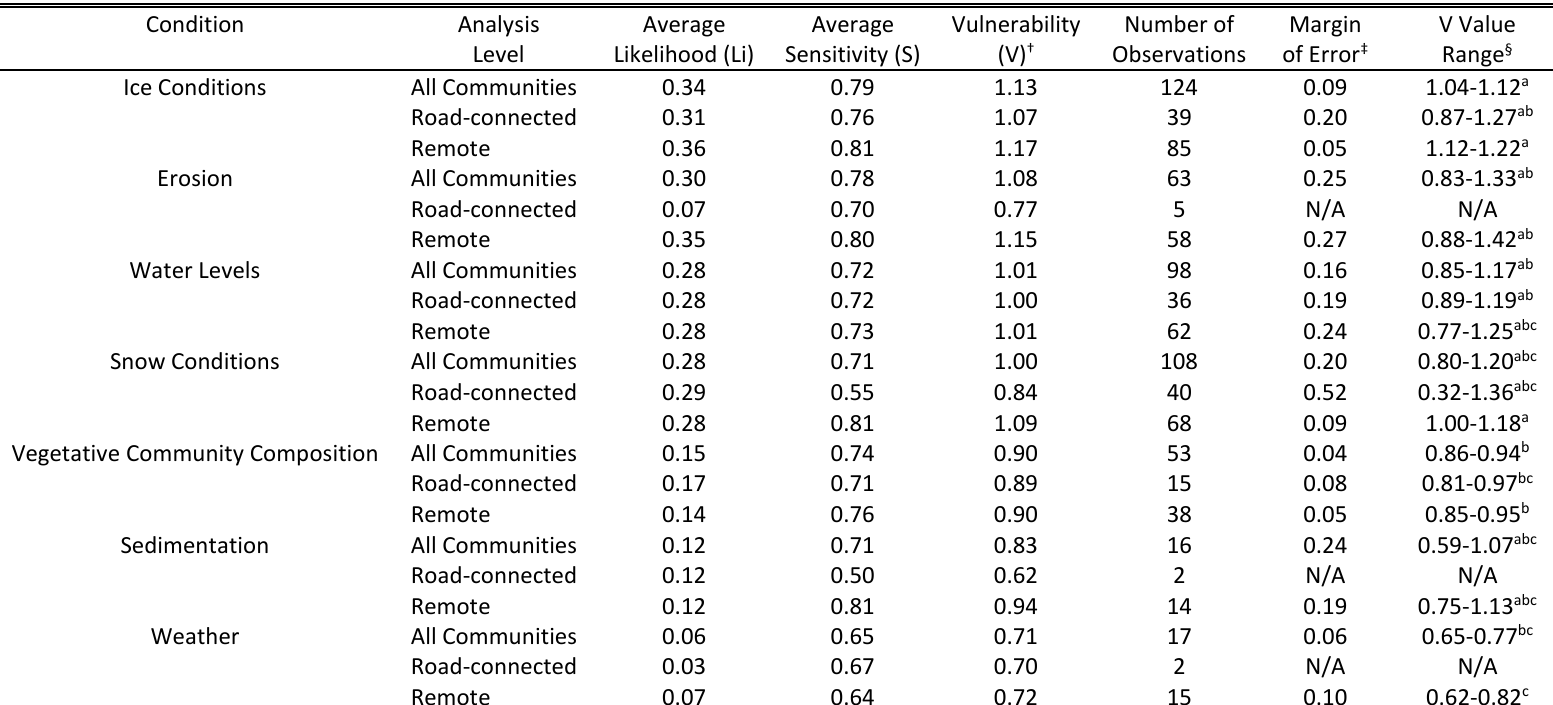
Table A3.2. Mean values for vulnerability analysis of interview data among 8 communities, 2 road-connected communities and 6 remote